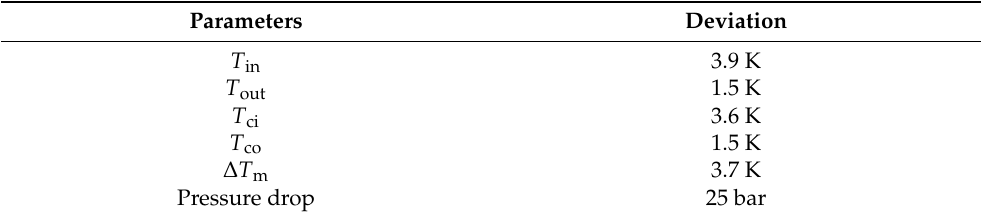
Table 3. Experimental uncertainties expressed by average